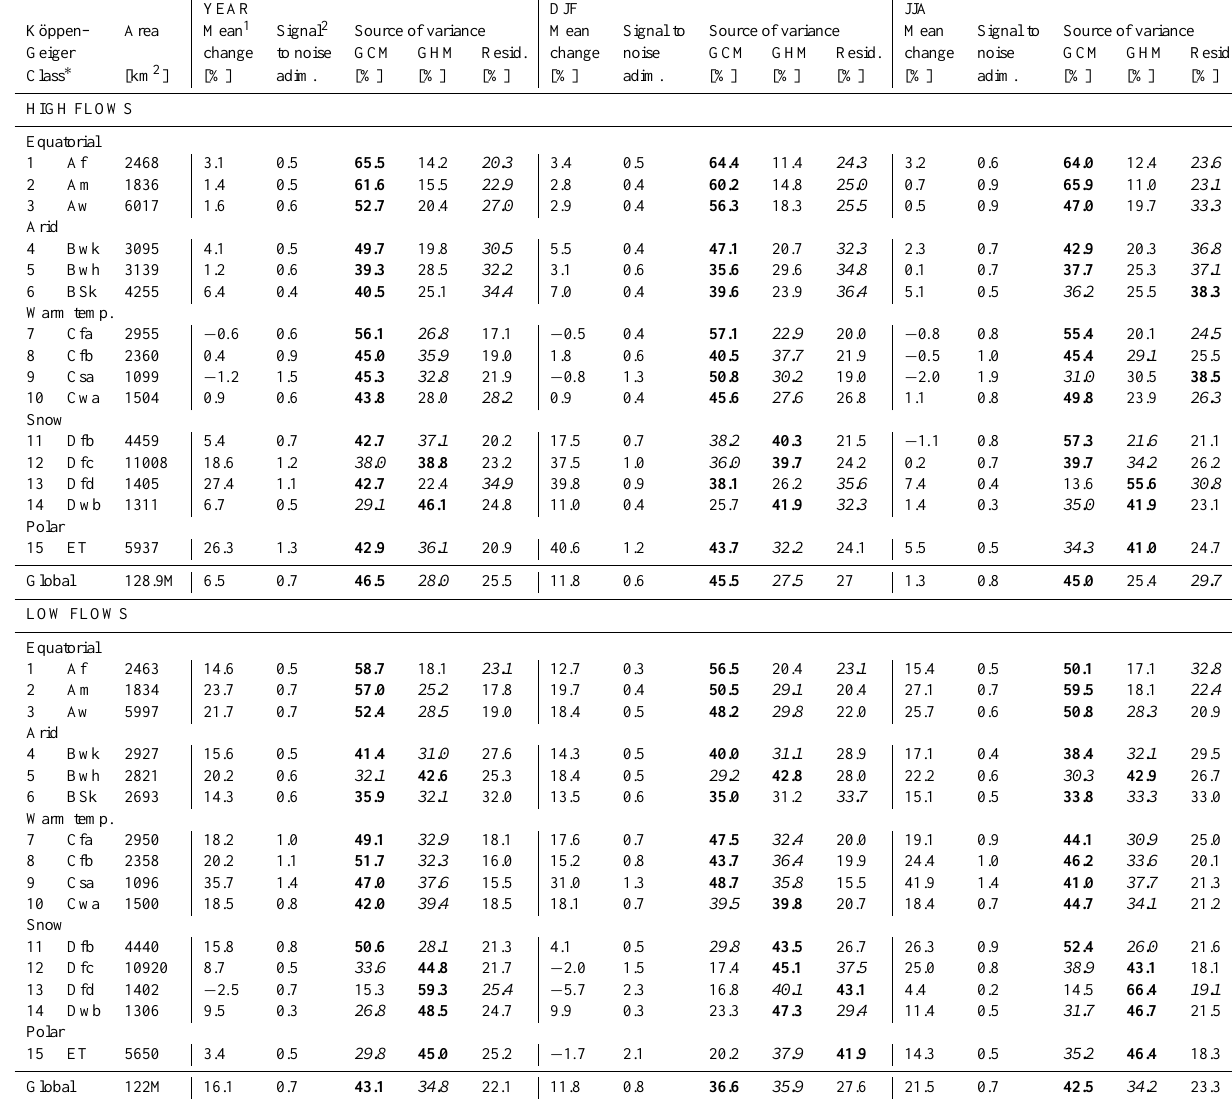
Table 1. Summary of mean changes, signal-to-noise S2N, and sources of variance for high and low flows at the annual and seasonal (DJF, JJA) scale, and at the global and climate region scale. The first source of variance is shown in bold, the second one in italic